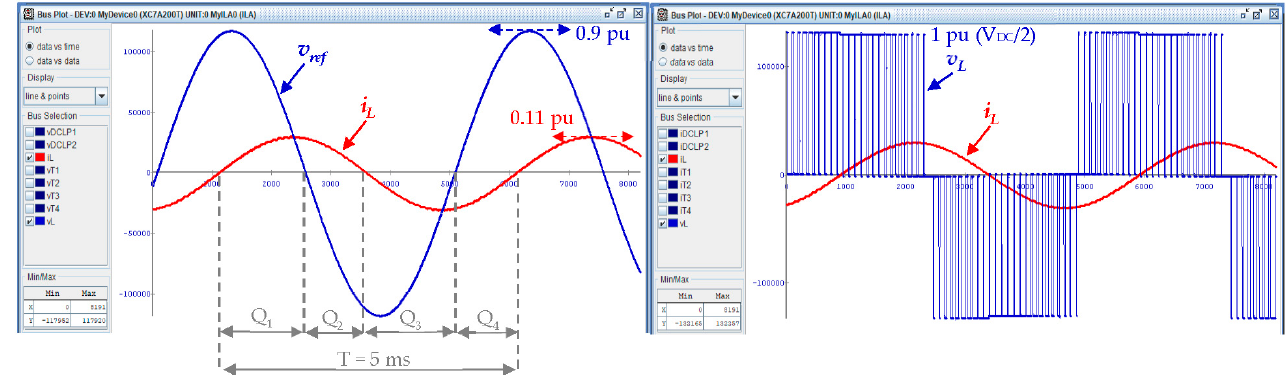
Figure 11. RT results for the half-bridge NPC inverter—load voltage/current waveforms.